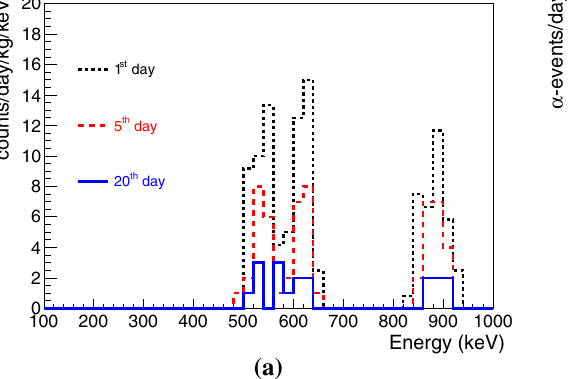
of time. A fit with an exponential plus a flat component was performed with the assumption that decreasing components originate from exter- nal contamination of 222 Rn and from its daughter particle decays, while the flat component is produced by long lived isotopes in the 238 U chain that are intrinsic to the